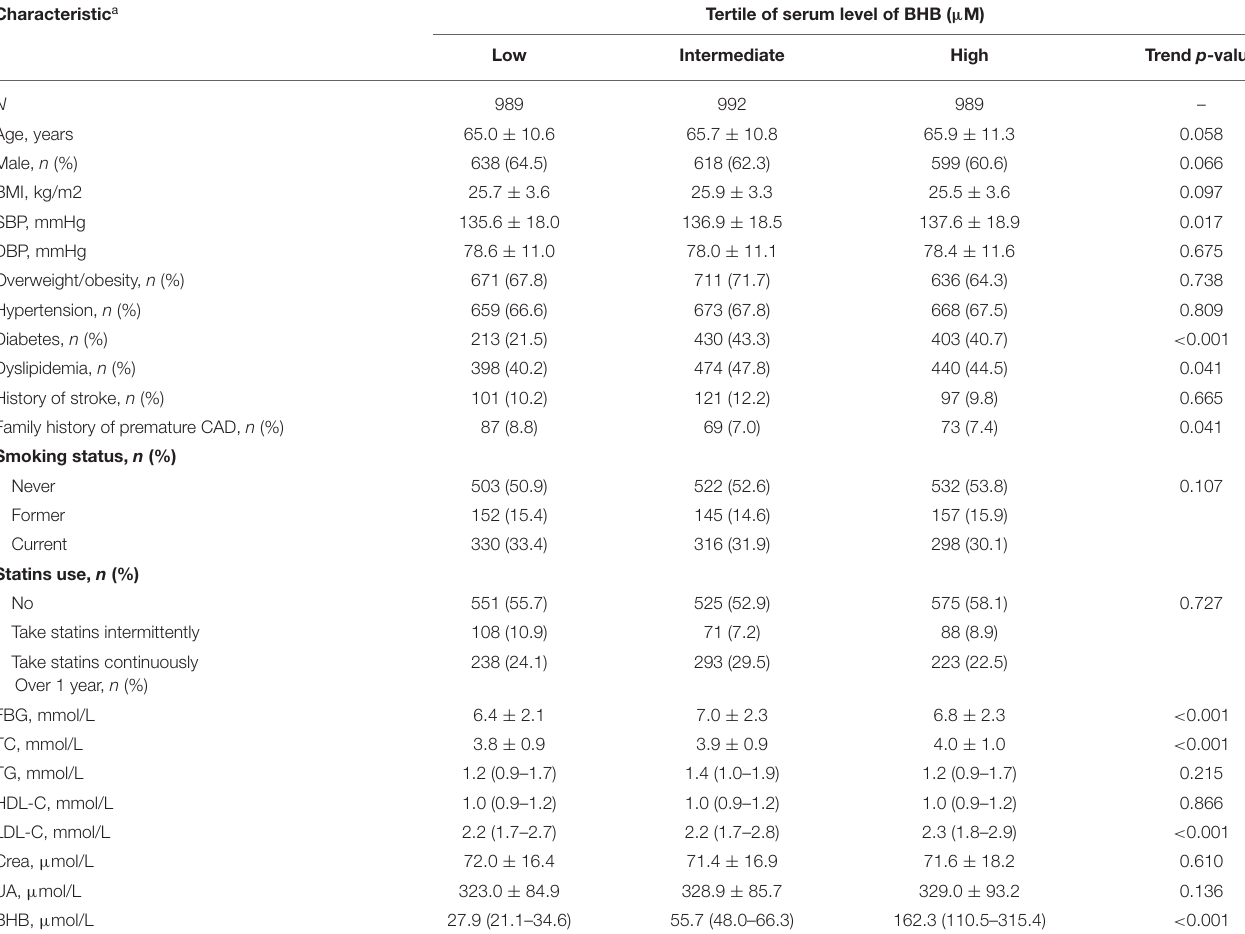
TABLE 1 | Comparison of baseline characteristics of study population according to serum BHB tertile. Characteristic